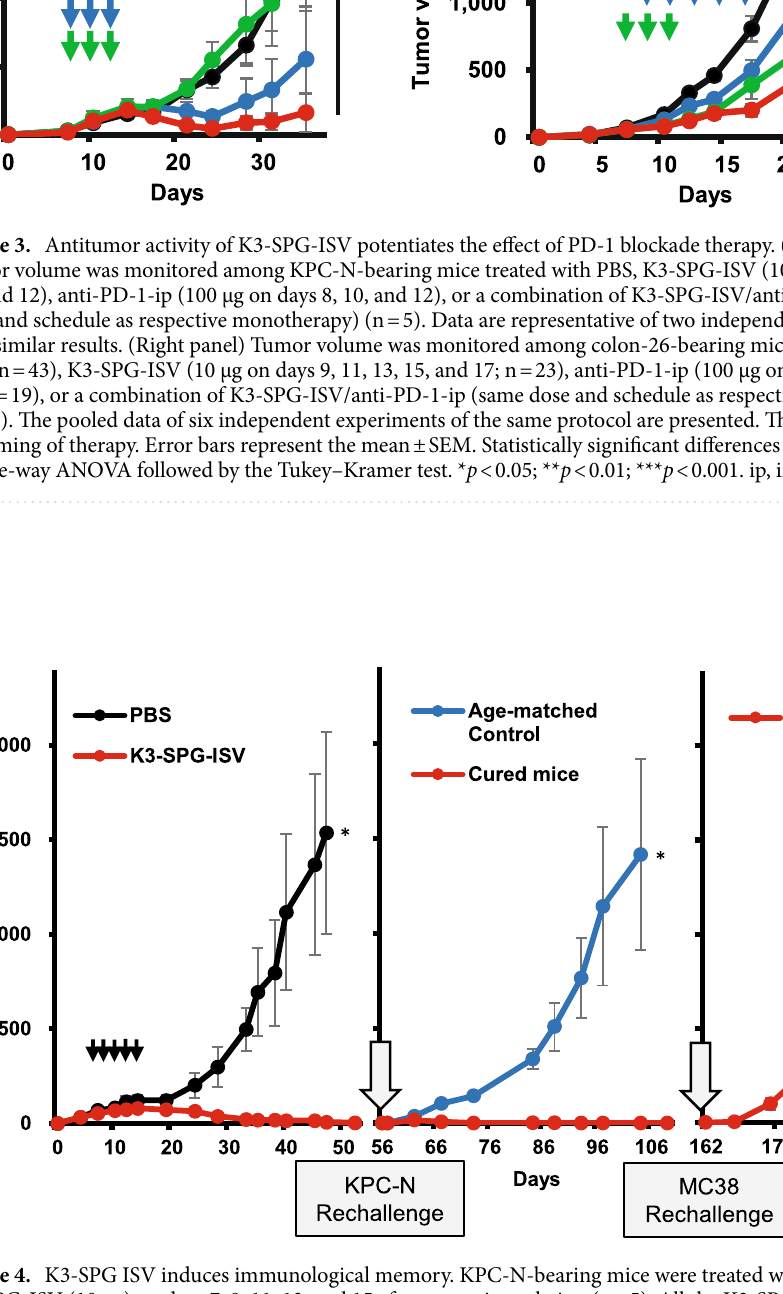
Figure 4. K3-SPG ISV induces immunological memory. KPC-N-bearing mice were treated with PBS or K3-SPG-ISV (10 μg) on days 7, 9, 11, 13, and 15 after tumor inoculation (n = 5). All the K3-SPG-ISV-treated mice were cured. On day 56, the cured mice were rechallenged with the second round of subcutaneous inoculation of 2 × 10 6 KPC-N and age-matched naïve C57BL6 mice (n = 5) were subcutaneously inoculated with the same number of KPC-N as a control cohort. All cured mice rejected rechallenge with KPC-N. On day 162, they were subcutaneously challenged with 2 × 10 6 MC38 cells. The tumor growth curves over the entire time course are presented. Data are representative of two independent experiments with similar protocols and results. The arrows indicate the timing of therapy. Error bars represent the mean ± SEM. Statistically significant differences were measured by one-way ANOVA with Dunnett’s post hoc test. * p <